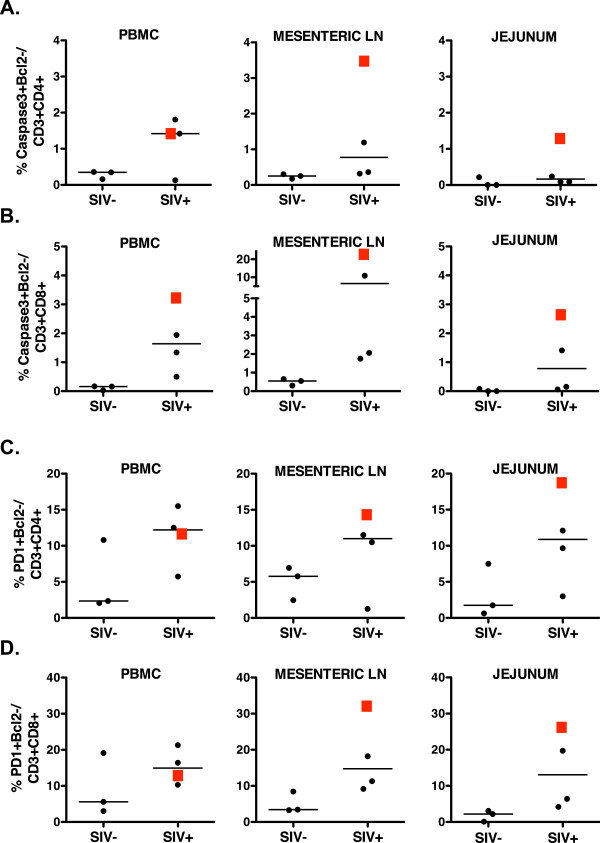
T cell apoptosis and exhaustion phenotype in SIV-infected rhesus macaques after tenofovir withdrawal and uninfected macaques. CD3 + 4+ T cells (A, C) and CD3 + 8+ T cells (B, D) from PBMC and tissue lymphoid cells were assessed via multiparameter flow cytometry for apoptotic cells, Caspase3 + Bcl2-, (A, B) and exhausted cells, PD-1 + Bcl2- (C, D). Data are reported as the frequency of the aforementioned cell populations in the CD4 + CD3+ or CD3 + CD8+ T cell populations, and are compared to those of 3 uninfected animals. Animal 33091 is represented as a red square in all graphs.